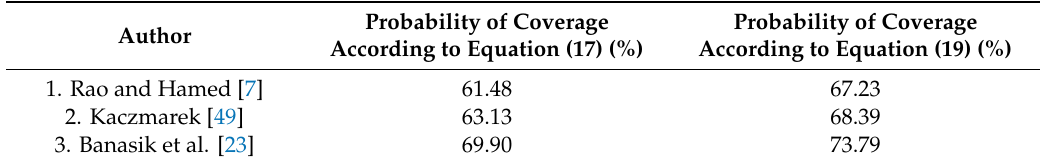
Table 3. The coverage probability of the true value of the quantile x 0.99 by the 68.3% confidence interval determined on the basis of Equations (17) and (19) for 10,000 samples of 50 elements and for three ways (authors) of the variance assessment of the quantile from Ga